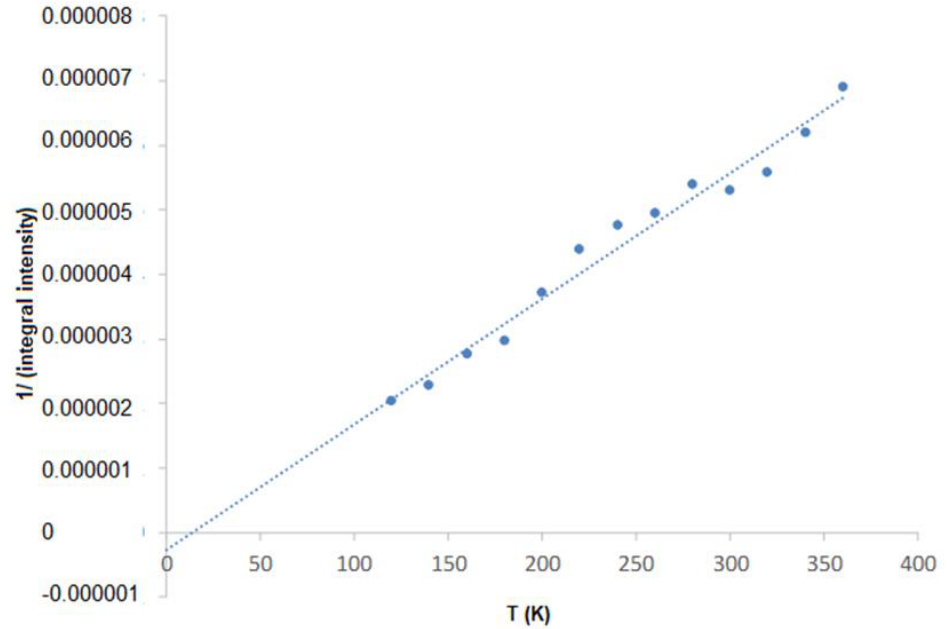
Figure 8. g eff as a function of the temperature for Pb 1+ (g eff ≈ 1.1).